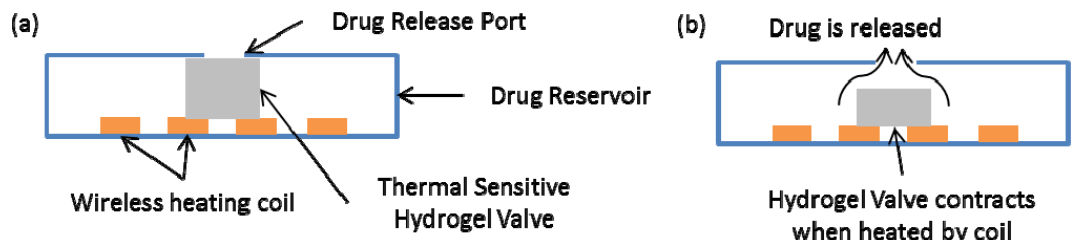
Figure 2. Illustration of a thermoelectric drug delivery device based on thermal sensitive hydrogel, redrawn from reference [35]. ( a ) Schematic view of the device. The